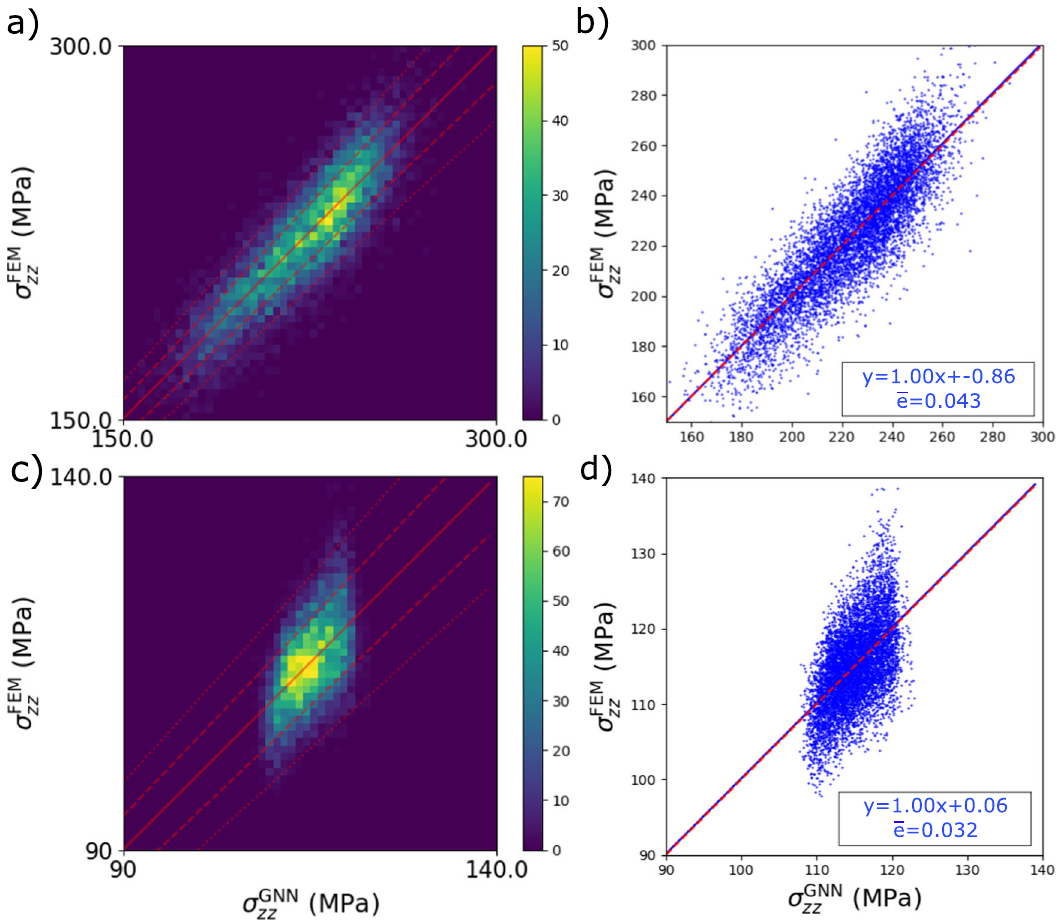
Fig. 4 Comparison of stress predictions along the loading direction ( σ zz ) from GNN surrogate models using lattice orientation as nodal features with CEFEM simulations. Histogram comparisons for a LSHR and c Ti-7Al. Also shown are scatter plots of the same comparisons for b LSHR and d